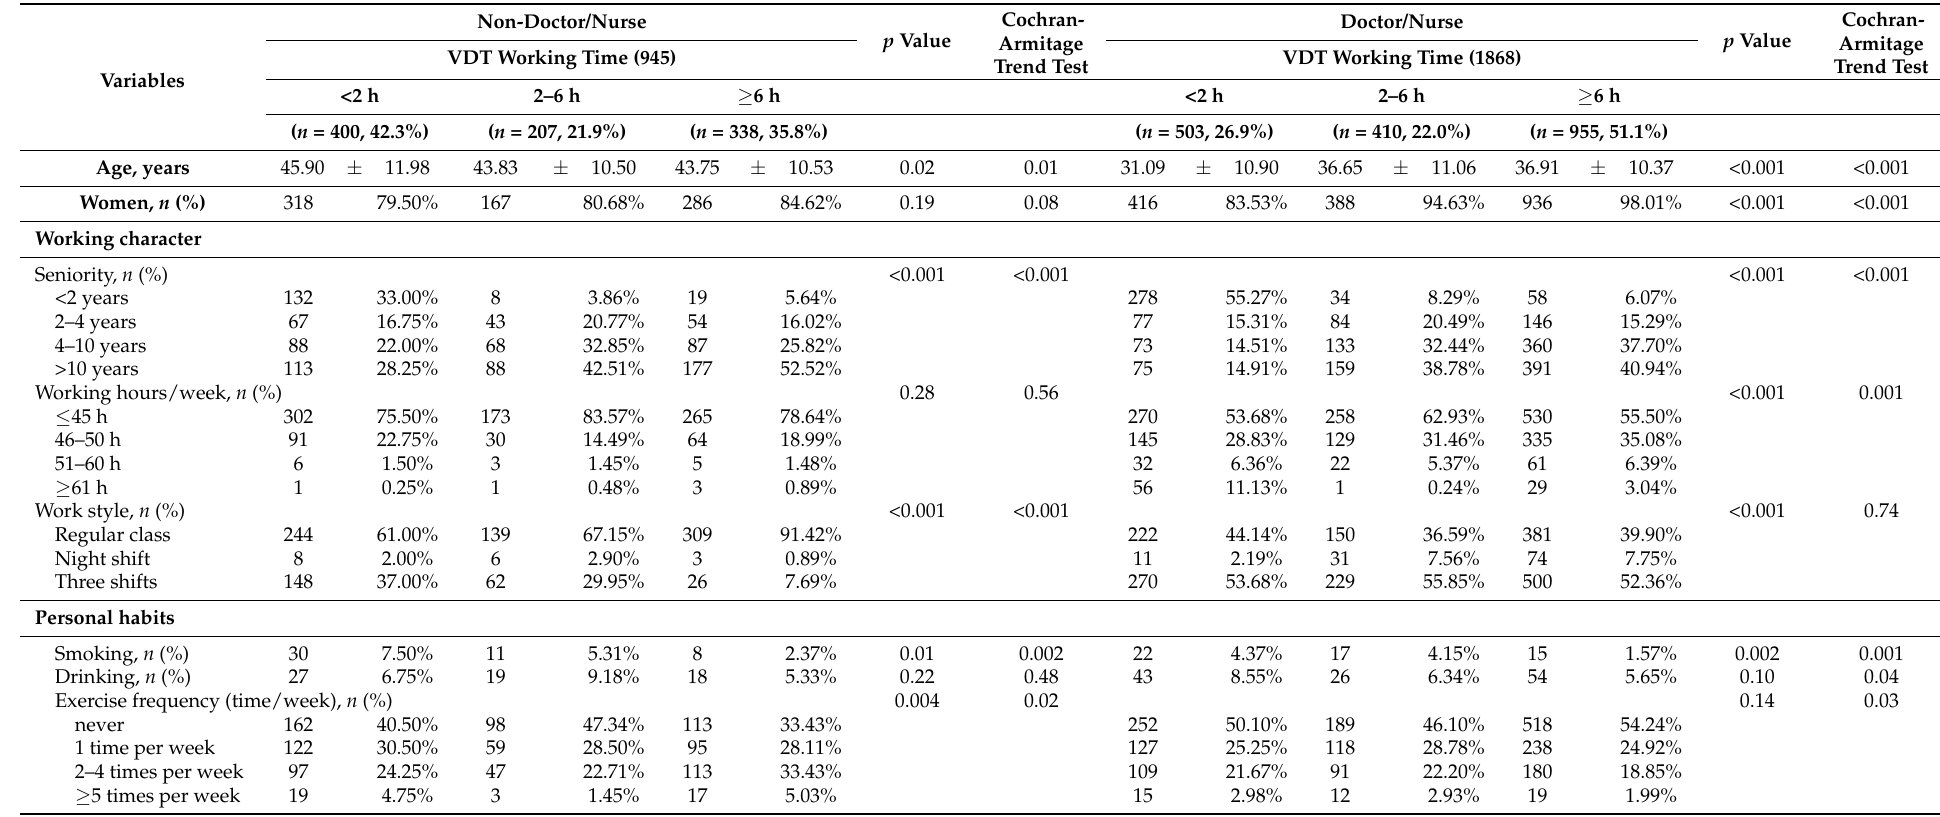
Table 1. Demography and characteristics of personal habits and work among different daily VDT working durations in hospital